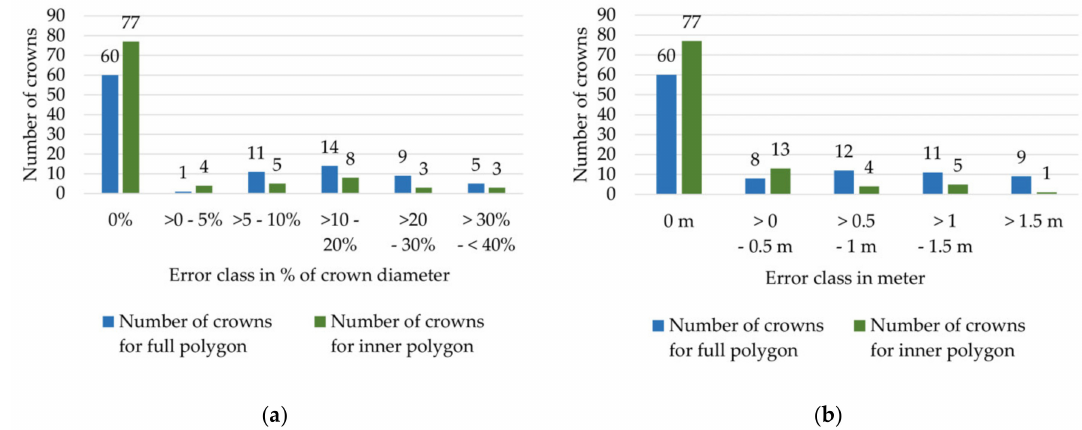
Figure A2. Spatial o ff set of crown polygons, edited on the LiDAR CHM, to the WorldView-2 image, measured for 100 randomly selected crowns. The o ff set is marked in classes with ( a ) the distance in percent from the crown diameter and ( b ) the absolute distance in meter. The blue values mark the o ff set for the full crown polygons, and the green values mark the o ff set for the inner bu ff er that was used in the analysis, after a 10% outer bu ff er was removed.